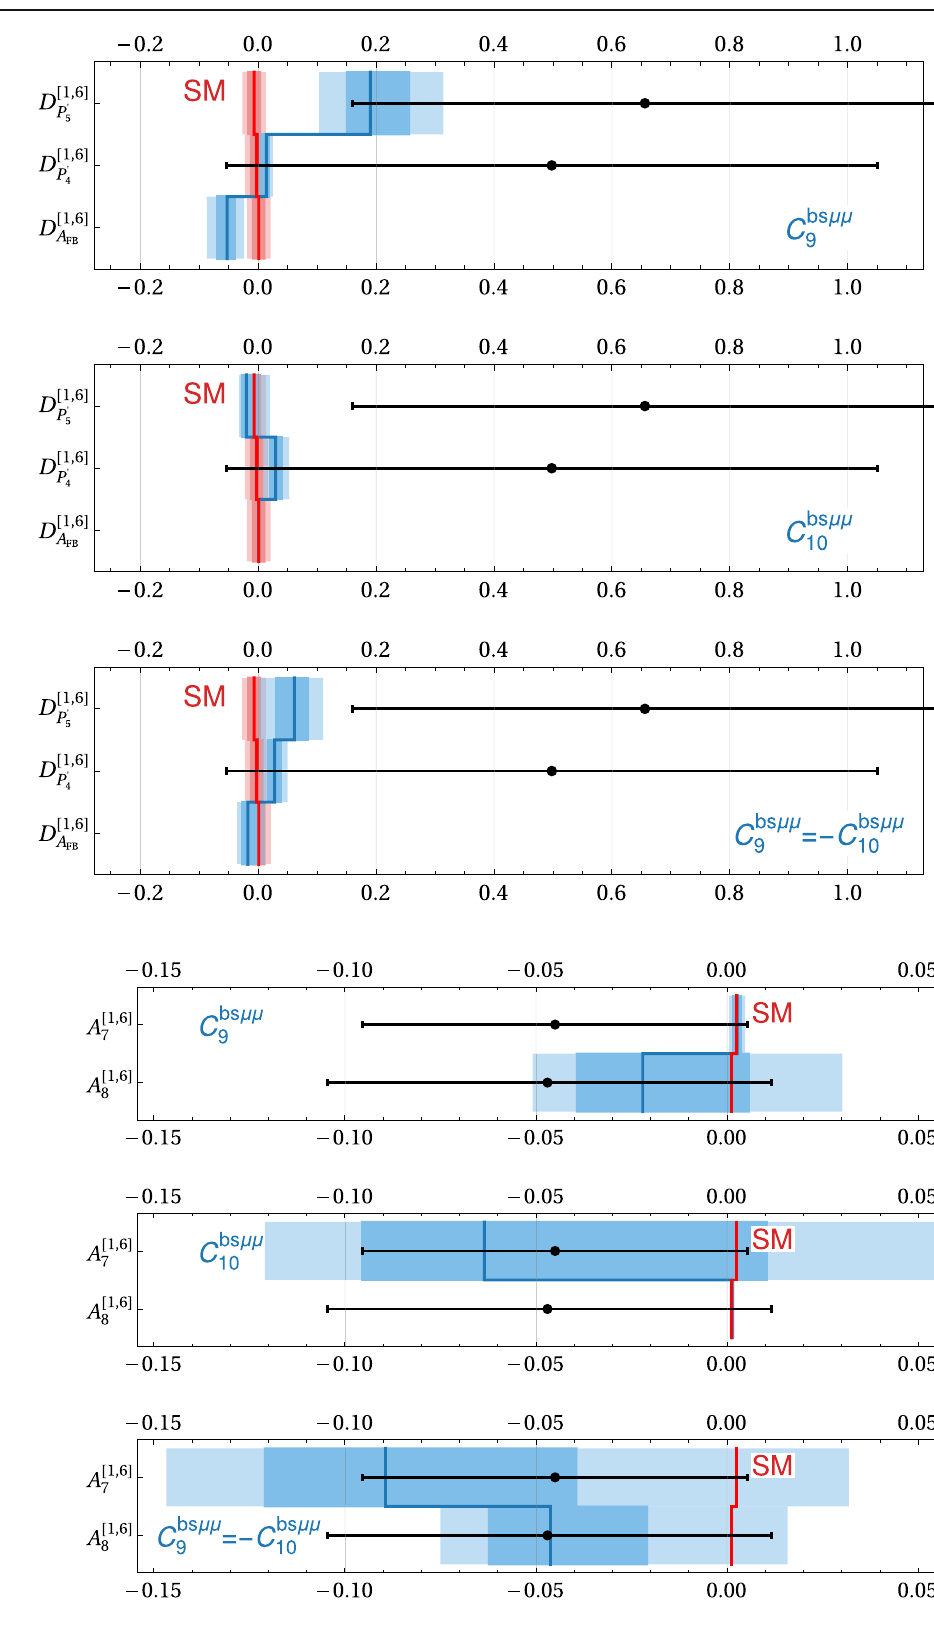
Fig. 10 Predictions for the CP asymmetries A 7 and A 8 in three new physics scenarios and the SM. For comparison the current measurements from LHCb [33] are shown as